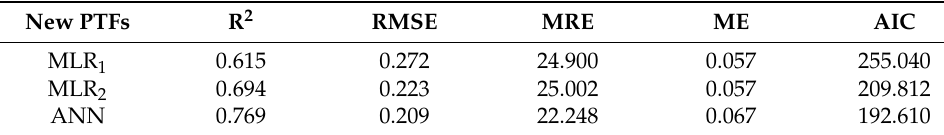
Figure 6. Comparison of the predicted and measured values of K S of the new PTFs developed by MLR and ANN. Table 6. Predictive performance of the newly established